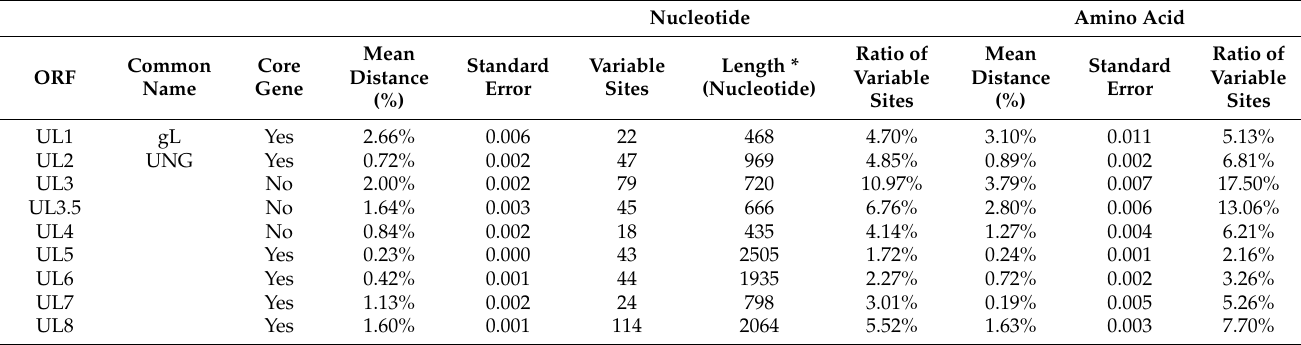
Table 1. Nucleotide and amino acid diversity of PRV strains in open reading